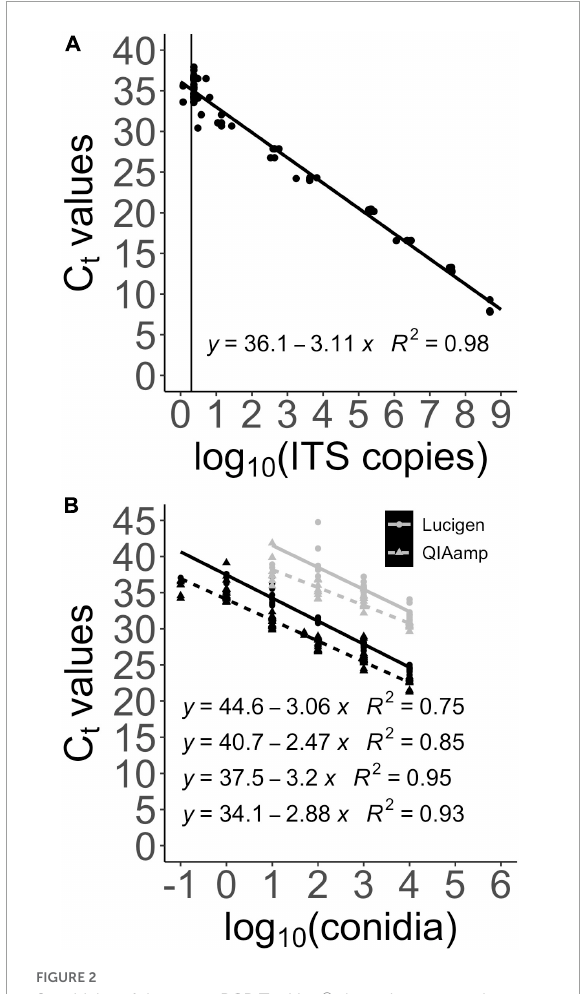
FIGURE2 Sensitivity of the new qPCR TaqMan R (cid:13) detection test against B. fagacearum and comparison of DNA extraction methods. Ct values obtained from running the qPCR TaqMan R (cid:13) assay are plotted against the log value of the number of ITS copies (gBlocks TM gene fragment) and conidia. Equations and coefficients R 2 are displayed on the graphs. (A) LOD of the newly designed qPCR TaqMan R (cid:13) assay on ITS copies (gBlocks TM gene fragment) is 2 ITS copies. (B) Comparison of the new qPCR TaqMan R (cid:13) detection test (black) and the old qPCR TaqMan R (cid:13) designed in the TEF region (gray) to detect B. fagacearum DNA extracted from various amount of conidia using the Lucigen (circle points) and QIAamp (triangle points)